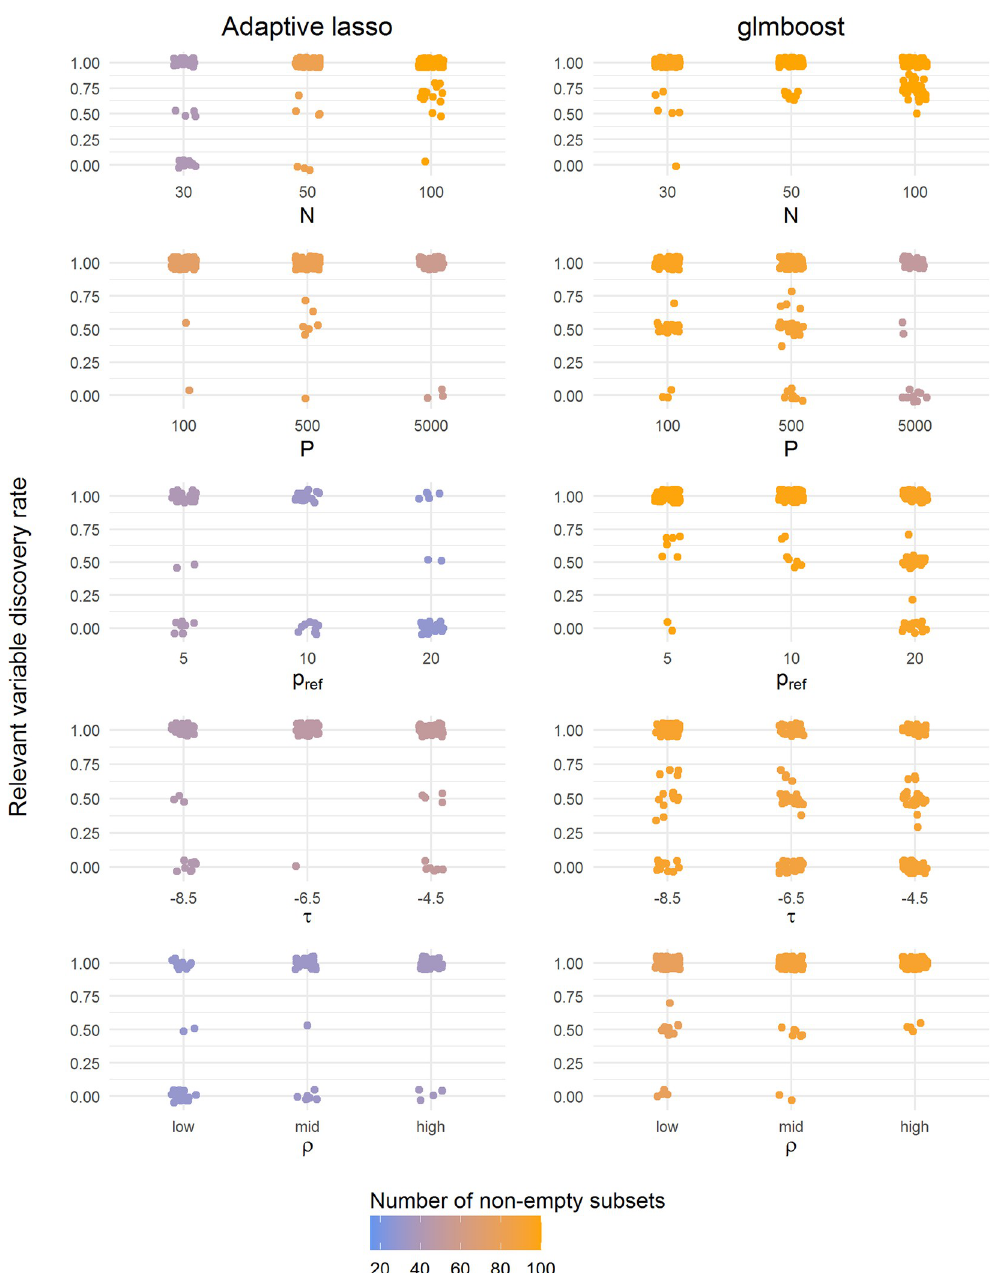
Fig 4. Summary of RVDR of each subset in all scenarios using adaptive lasso and glmboost. The colors represent the number of subsets resulting in at least one stable variable (blue: Low, orange: High). A total number of 100 realizations of simulated datasets were drawn for each